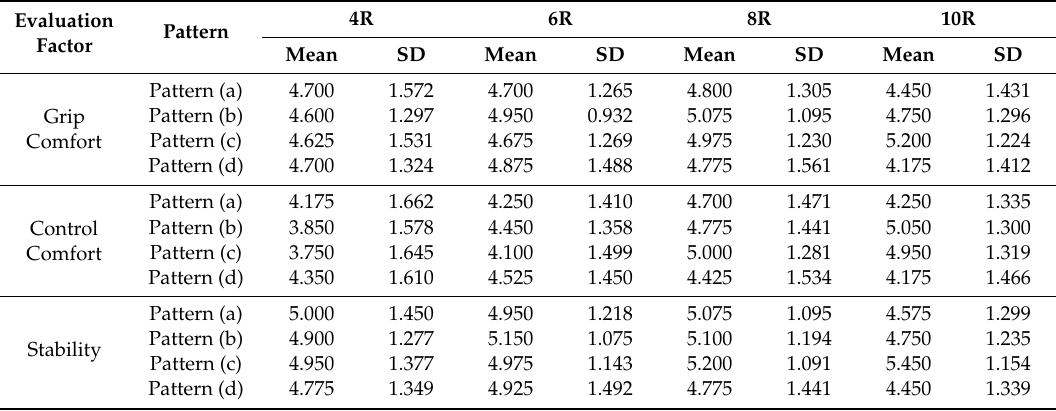
Table 12. Results of subjective evaluation for grip comfort, control comfort and